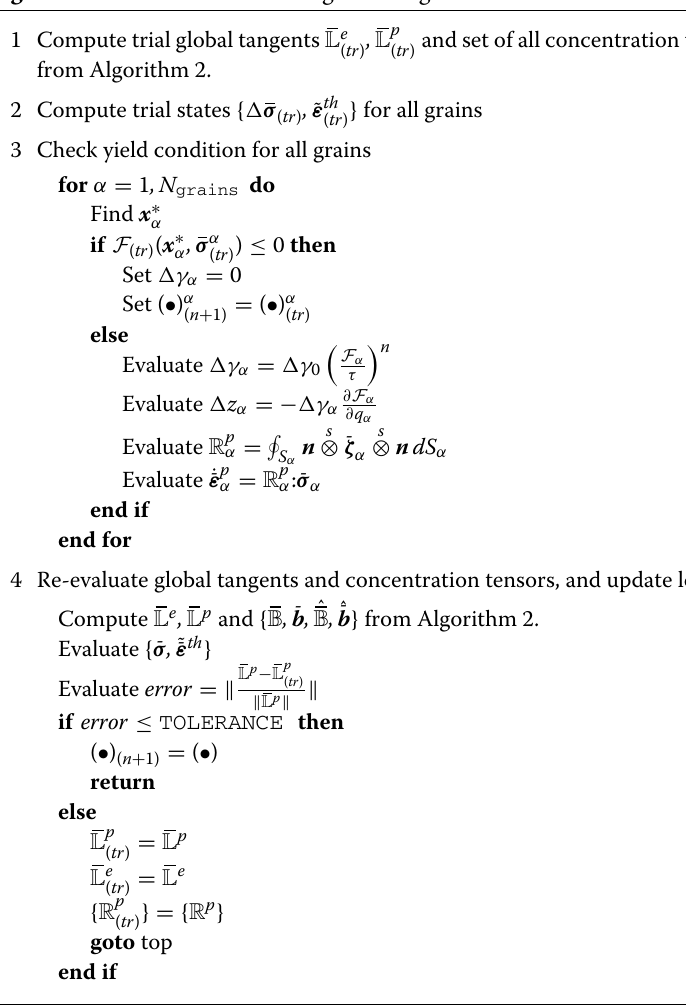
Algorithm 1 TEPSCA stress integration